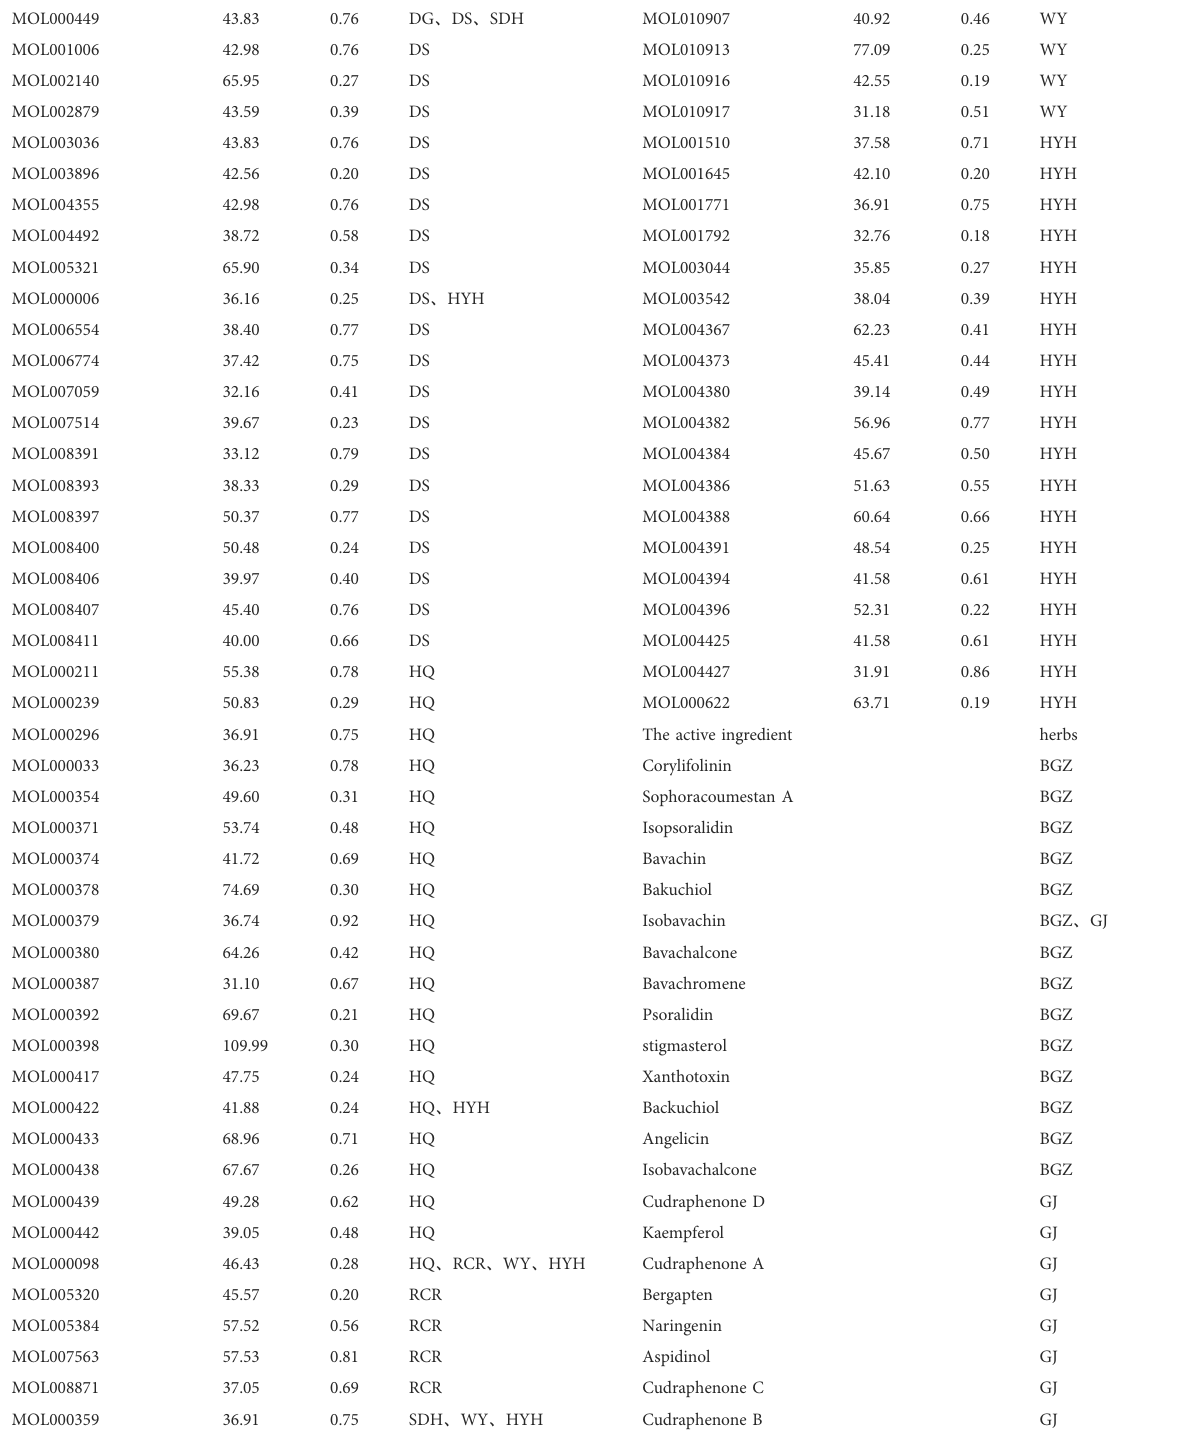
TABLE 1 Drug composition of Guben Zenggu granule. Seractial